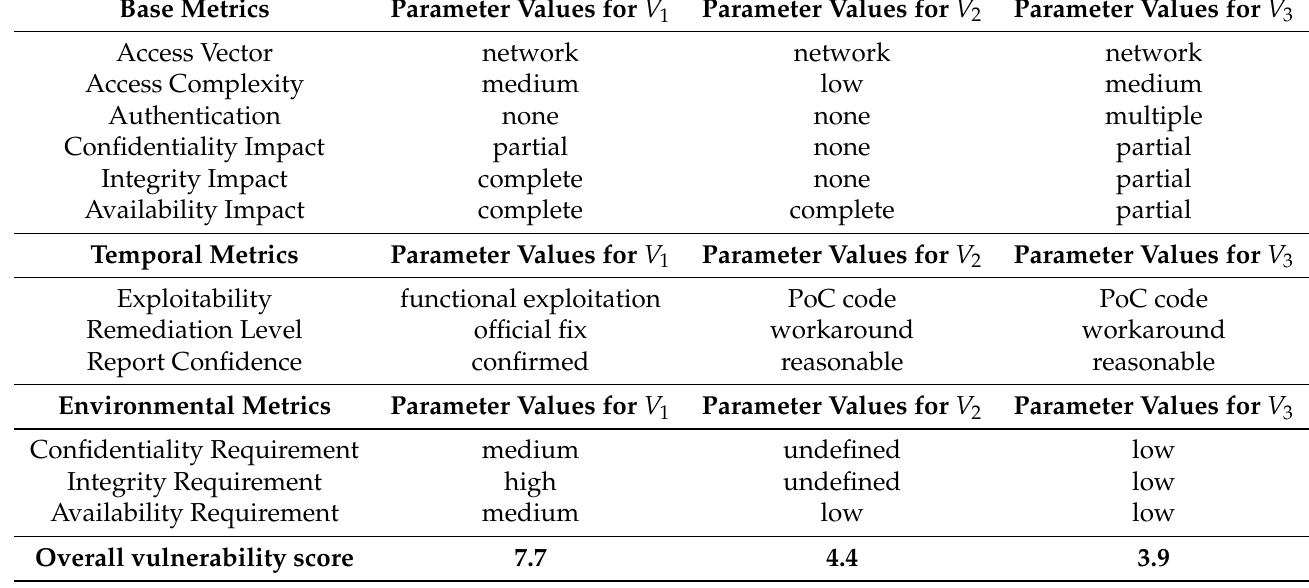
Table 4. Summary of the vulnerability analysis for the EVSE-CSO sub-systems communication. The parameter values indicate our choice to the different metrics of the CVSS methodology. Three different types of vulnerabilities V 1 , V 2 , and V 3 are identified for this